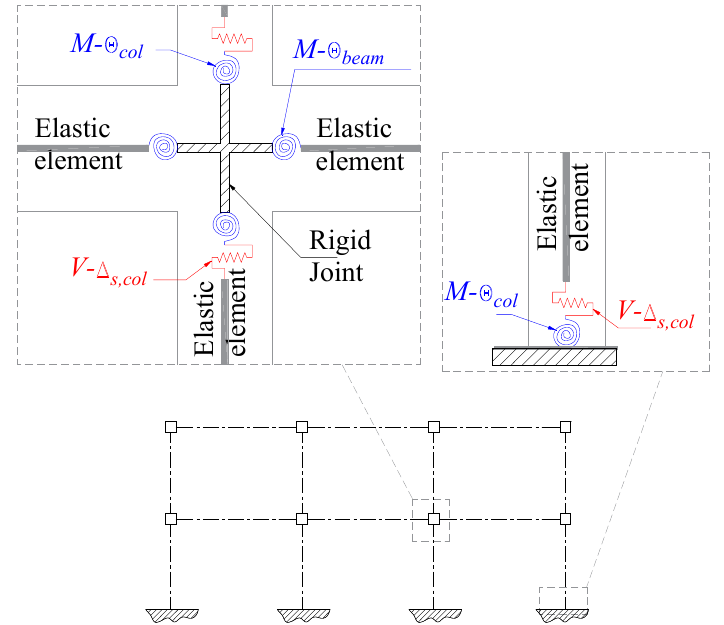
Figure 3. Nonlinear modelling approach adopted for RC elements.